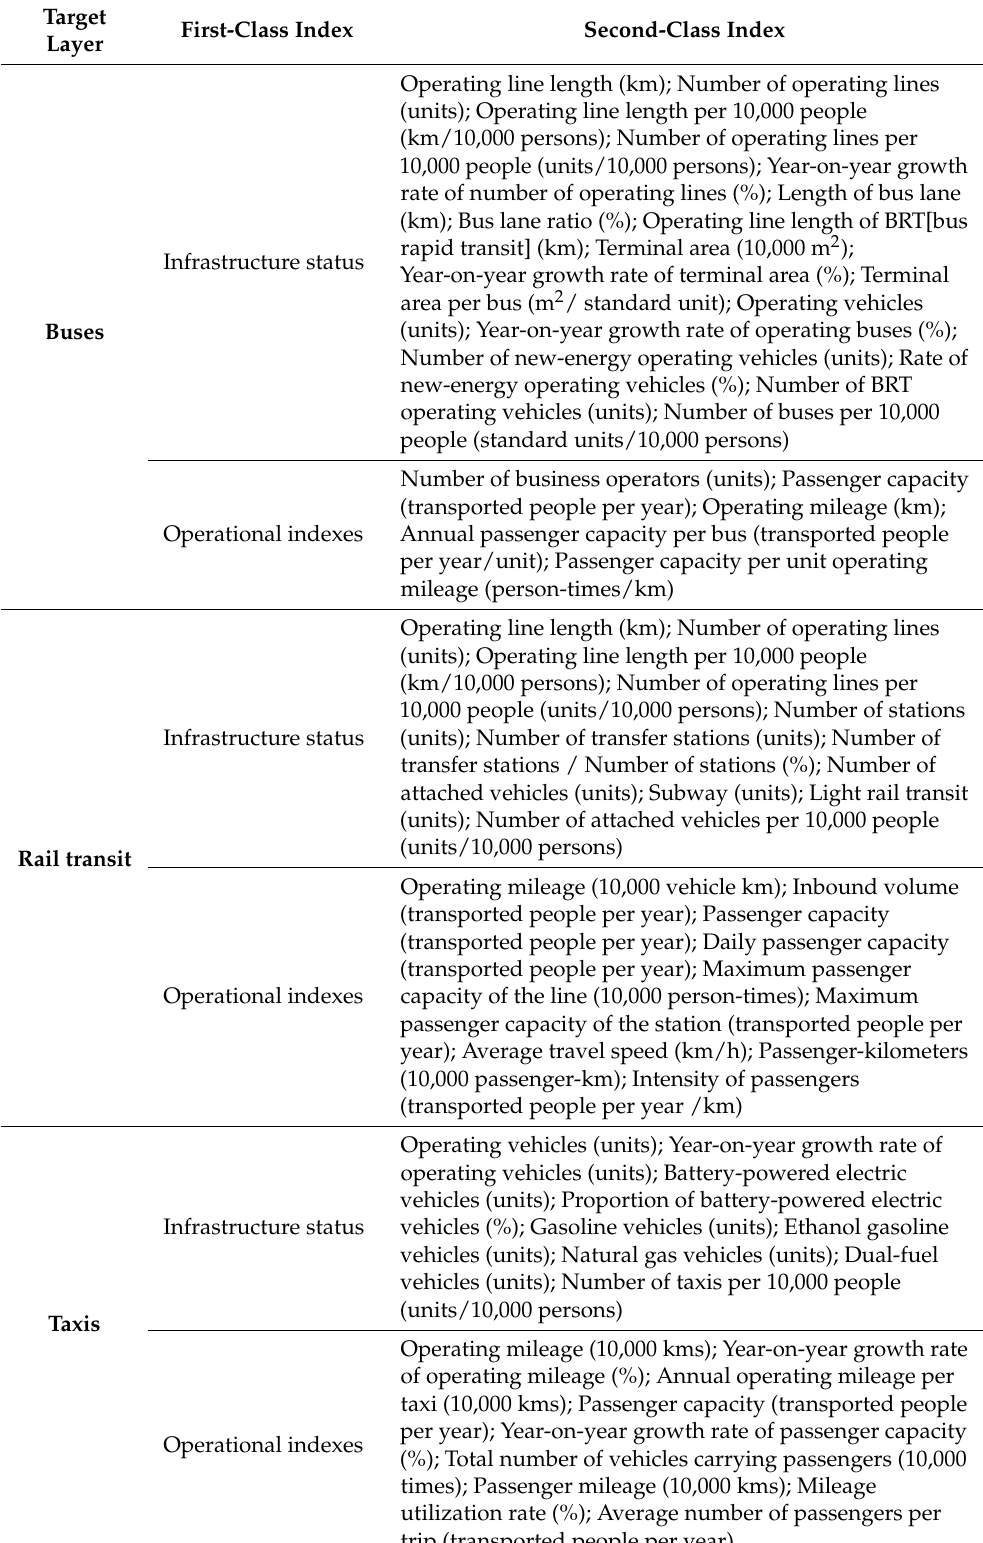
Table 1. Evaluation index system for the development level of urban multimodal